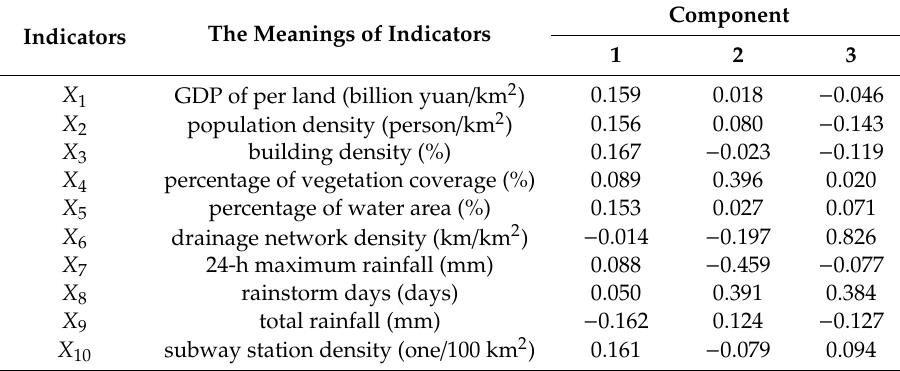
Table 3. Component score coe ffi cient